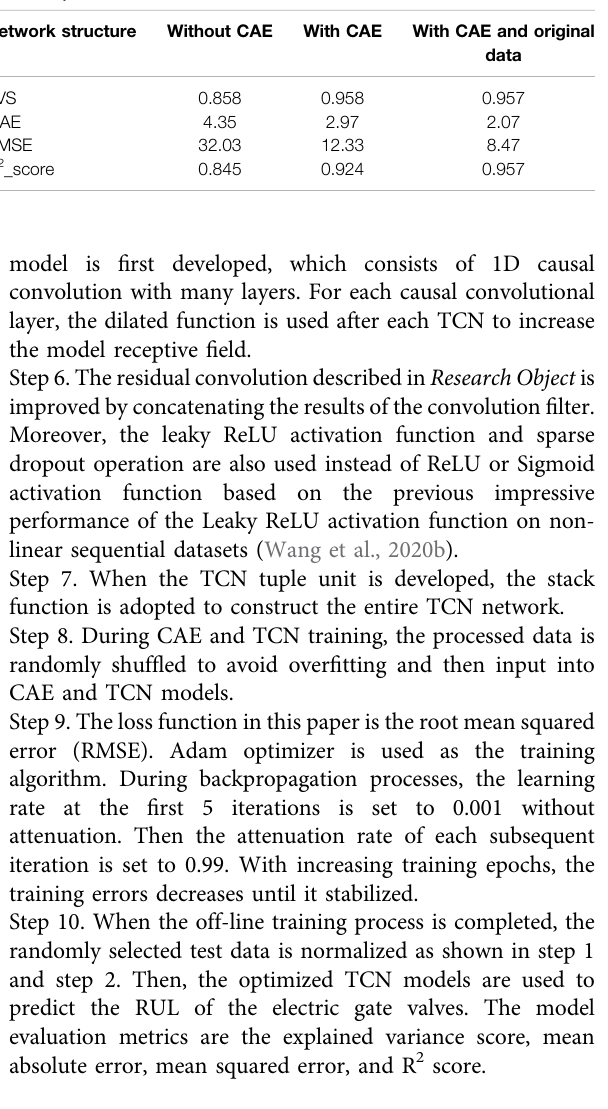
TABLE 3 | Average test loss with different layers and neurons of CAE.